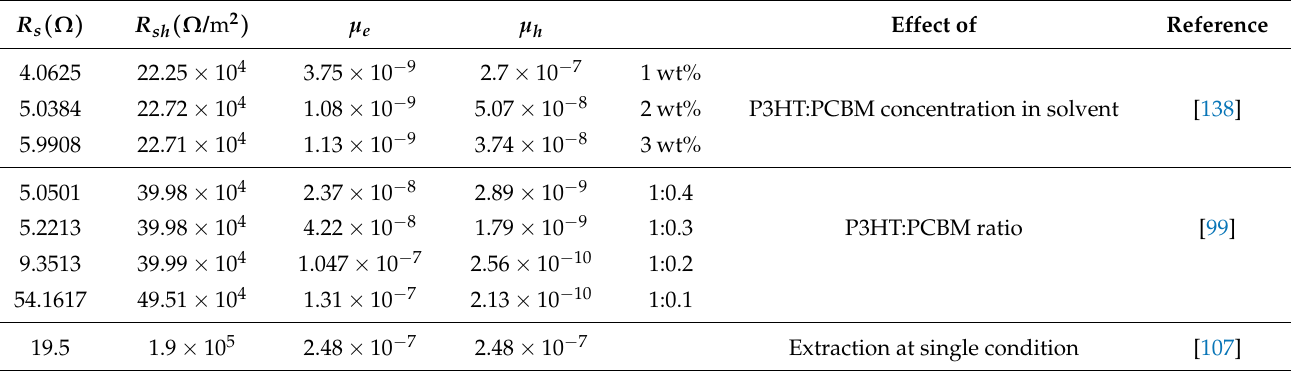
Table 3. Extracted parameters of different organic solar cells at different conditions. R s ( Ω ) Effect of Reference